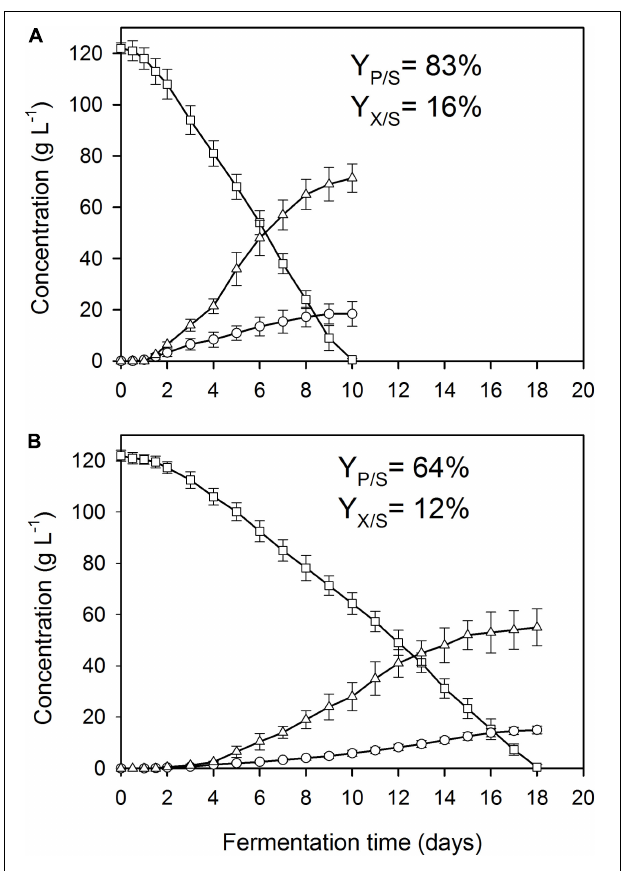
FIGURE 1 | Kinetics of fungal biomass (O), itaconic acid ( (cid:77) ), and residual D -glucose ( (cid:3) ) concentrations in controlled batch fermentations of A. terreus NRRL 1960, grown in a 2-L scale bioreactor in the presence of 3 µ g L − 1 Mn 2 + ions (manganese limitation). The variables share the same y -axis as they are expressed in the same unit (g L − 1 ). Y p / s , molar itaconic acid yield; Y x / s , biomass (DCW) yield. (A) Culture supplemented with 3.3 mg L − 1 Cu 2 + ions. (B) Culture supplemented with 0.01 mg L − 1 Cu 2 +